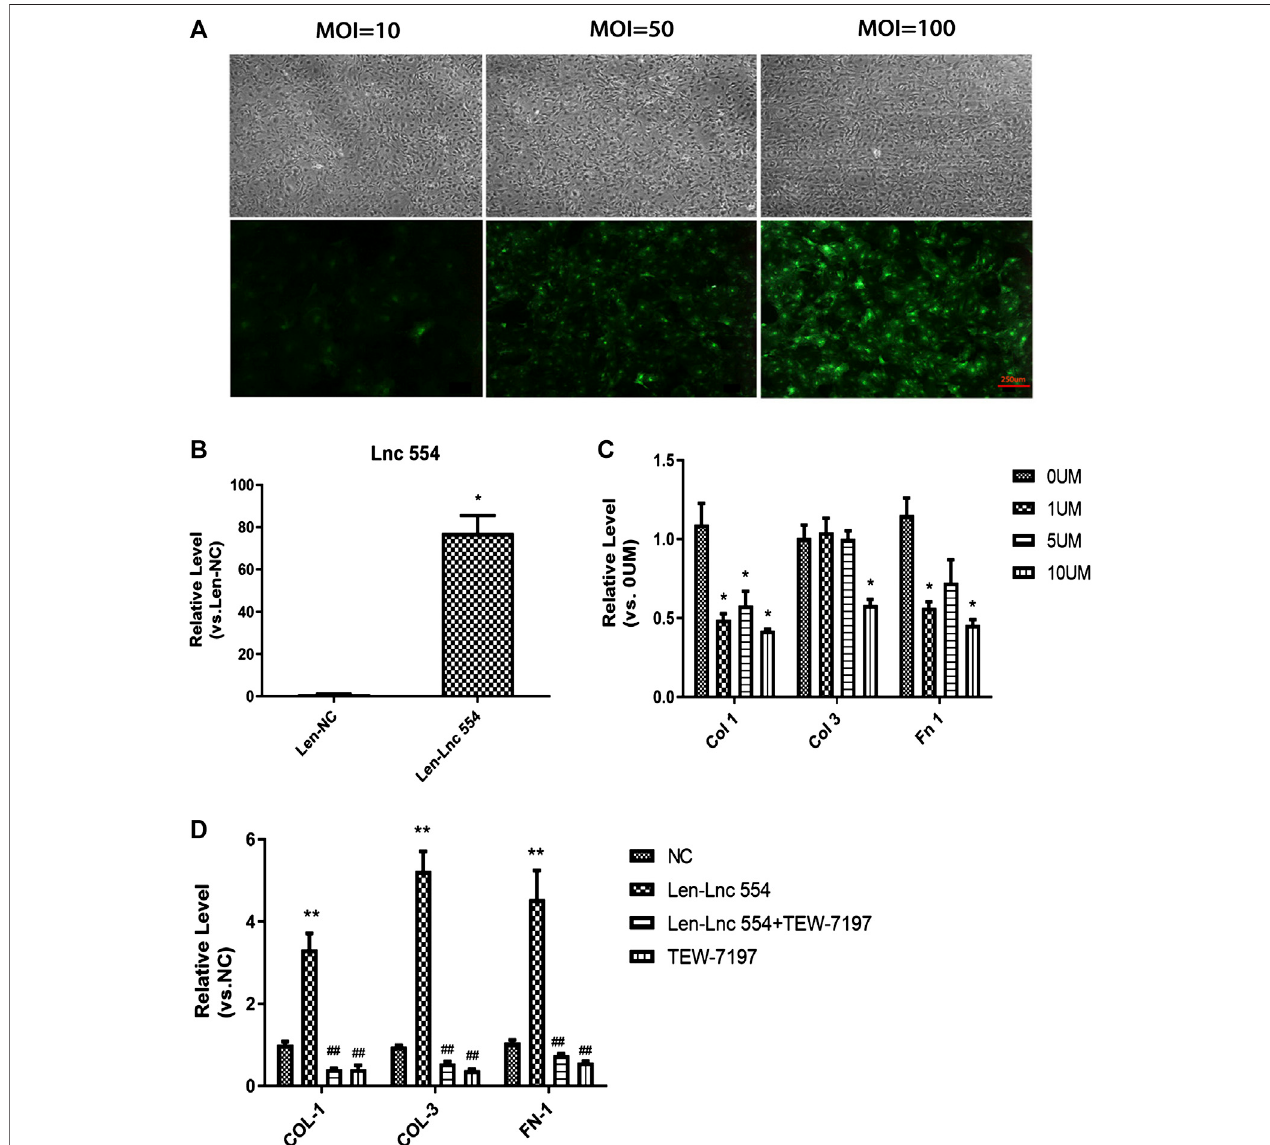
FIGURE3| LncRNA 554regulatescardiac fi brosisviaTGF- β 1signalpathway invitro (A) Representativeimages ofGFP fl uorescenceintensityofdifferentMOI(10, 50and100)showtheinfectionef fi ciencyoflentivirus.n (cid:2) 5.Scalebars,250 μ m; (B) TheleveloflncRNA554overexpressionbylentiviruswasanalyzedbyqRT-PCR.* p < 0.05 vs NC,n (cid:2) 5; (C) The level ofECMmRNA inCFs treated withdifferent concentrationTGF- β 1inhibitor (TEW-7197) (0, 1,5and 10 μ M). * p < 0.05 vs0 μ M, n (cid:2) 5; (D) TheCFsweretreatedwithlentivirus-NC,lentivirus-lncRNA554and(or)TEW-7197.qRT-PCRwasconductedtodetectECMlevels(Col1,Col3,Fn1).** p < 0.01vs NC, ## p < 0.01 vs Len-Lnc 554, n (cid:2) 5. NC or Len-NC, empty lentivirus group; Len-Lnc554, lncRNA 554 overexpression group.